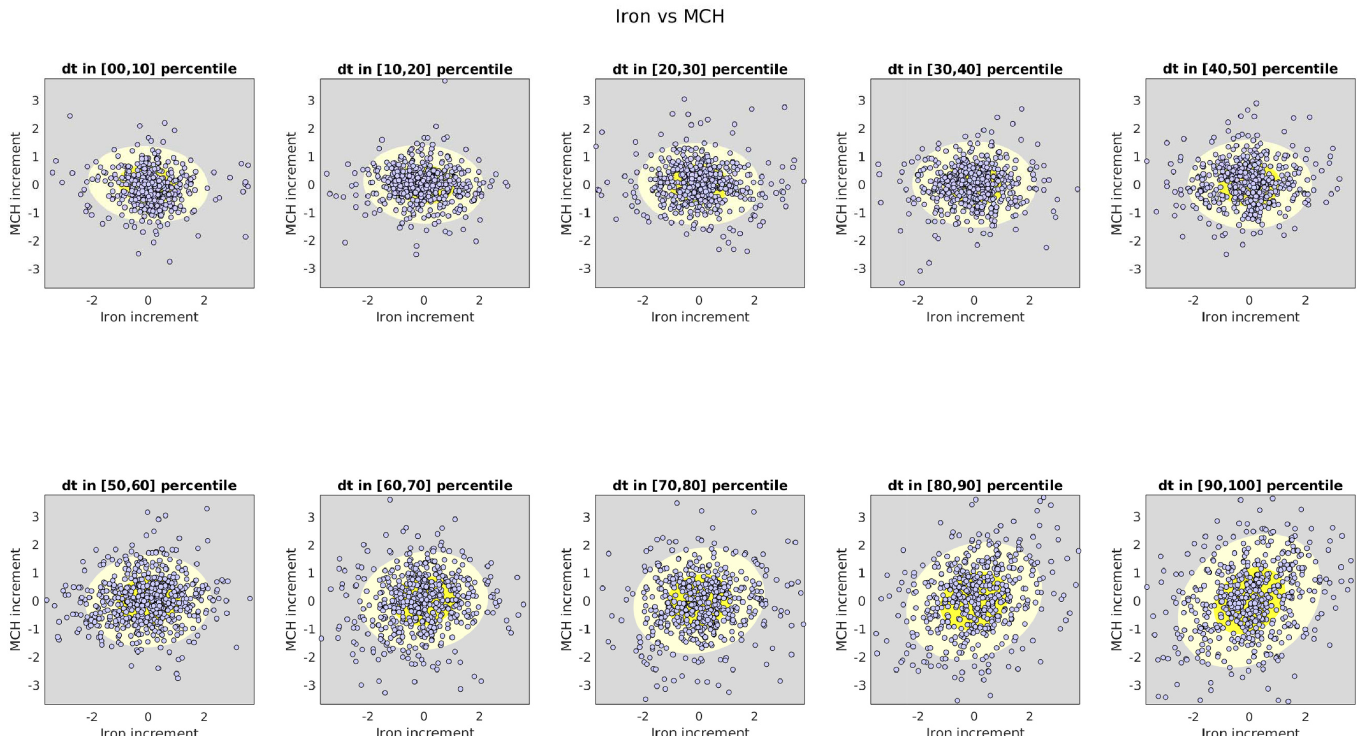
Fig 5. Model of Iron vs MCH: B and C. Here we illustrate the type-B and type-C variations associated with Iron (horizontal) and MCH (vertical). Each subplot shows a scatterplot of variable-increments for a percentile-band of observed time-increments. The yellow ellipses correspond to standard-deviation contours of the best-fit Gaussian distribution within each